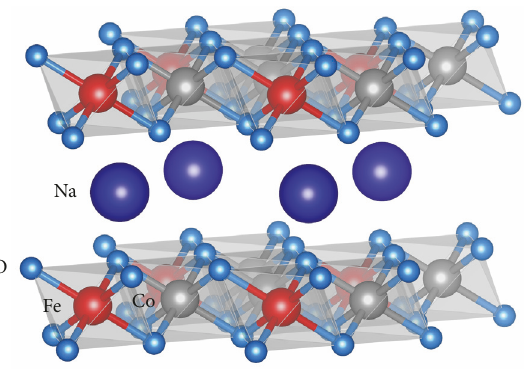
Figure 1: (Color online) Sketch of a Fe-doped Na 𝑥 CoO 2 structure. Notethatthevirtual-crystalapproximationisemployedintheactual